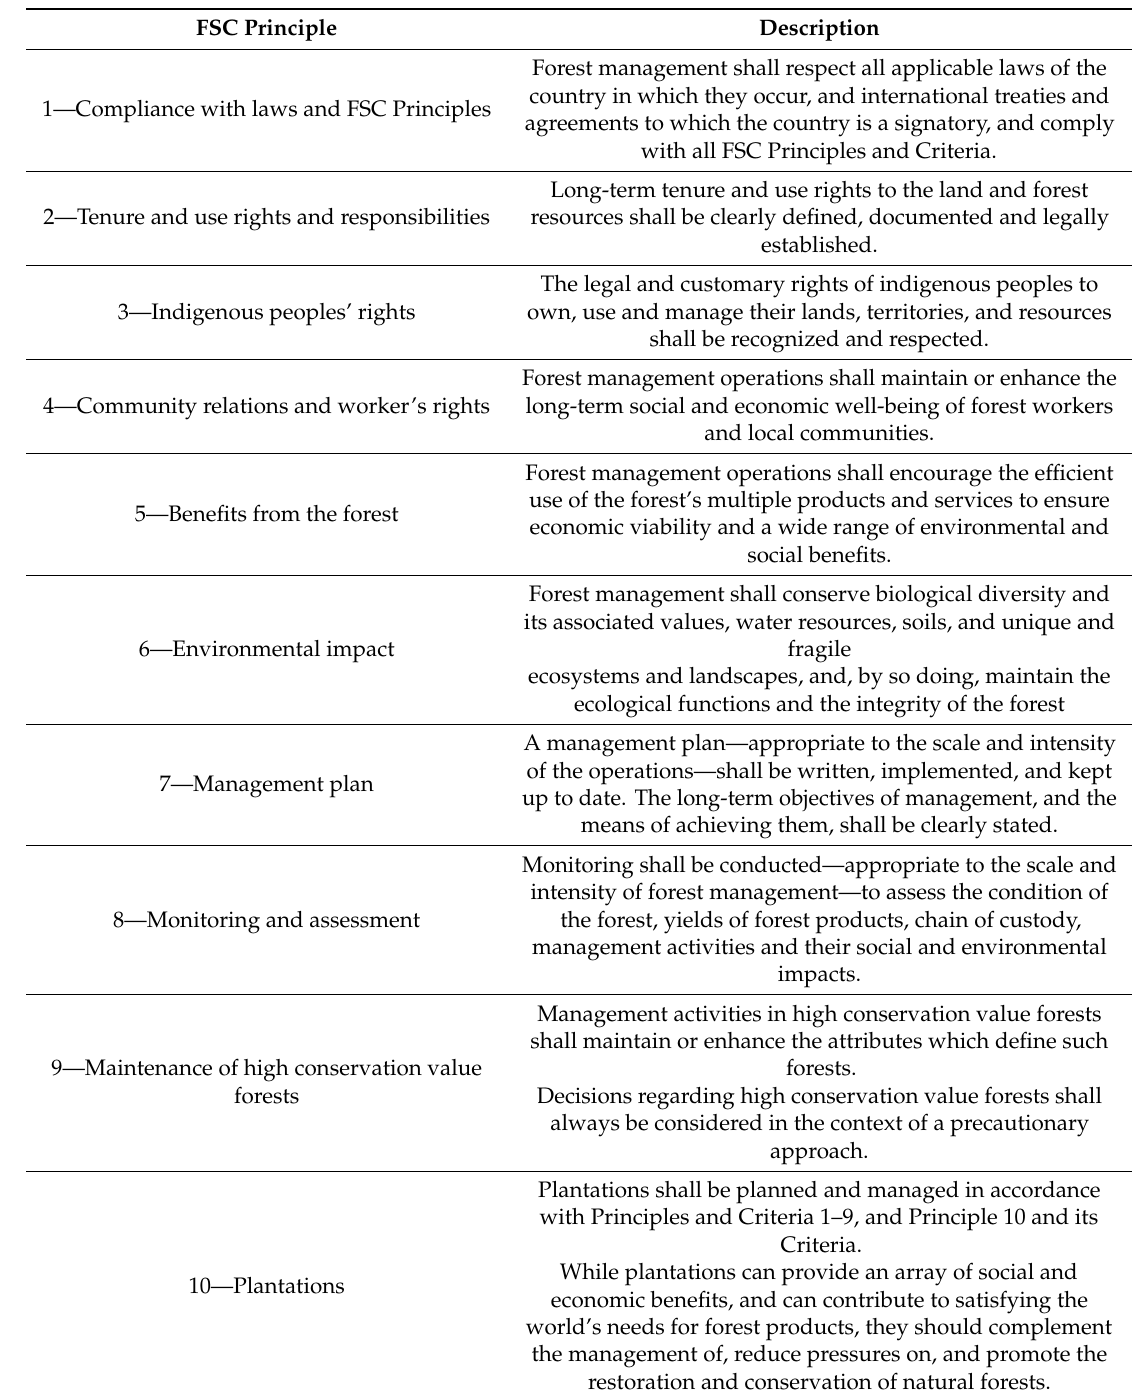
Table 3. The ten FSC Principles A,B